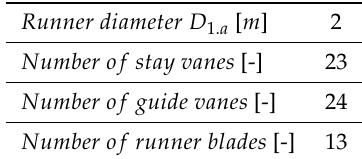
Table 1. Main geometrical properties of the